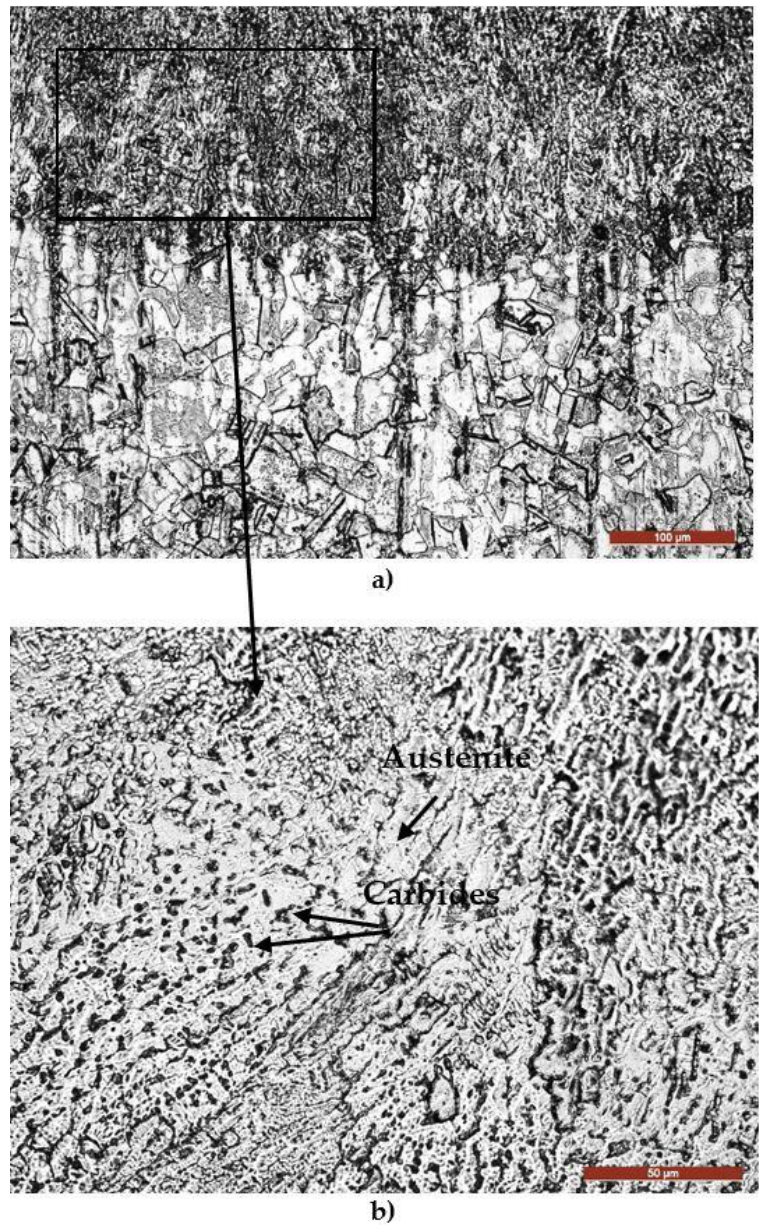
Figure 12. The microstructure of the layer—substrate system during the local TIG surface remelting with Is = 150 A: ( a )—layer—substrate interface; ( b )—remelted layer.